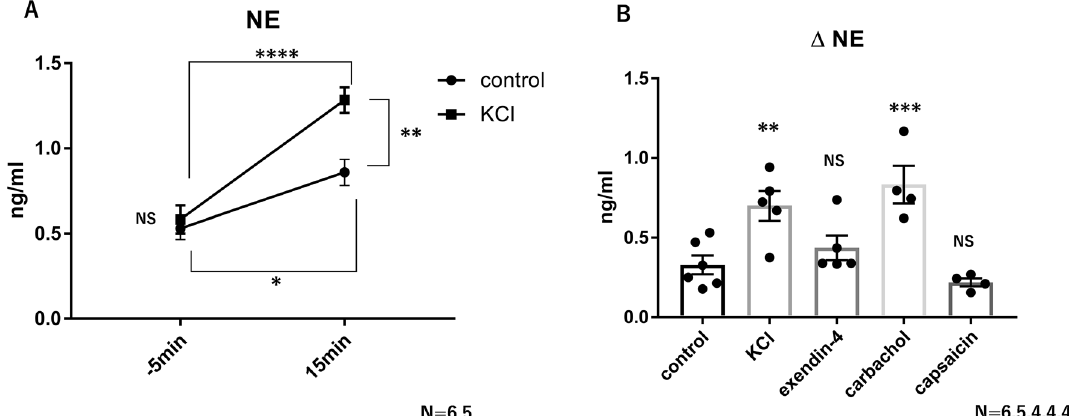
Figure 3. NE from sympathetic nerves passes into the intestinal lumen. ( A ) Measurement of norepinephrine concentration on the mucosal side before and after KCl administration to the serosal side of the cecum (control, n = 6; KCl, n = 5). ( B ) Change in norepinephrine concentration on the mucosal side after the administration of various drugs to the serosal side of the cecum (control, n = 6; KCl, n = 5; exendin-4, n = 4; carbachol, n = 4; capsaicin, n = 4). All values represent the mean ± SEM. * P < 0.05, ** P < 0.01, *** P < 0.001; NS, not significant by two-way ANOVA with multiple comparison ( A ) or one-way ANOVA with multiple comparison ( B ). All